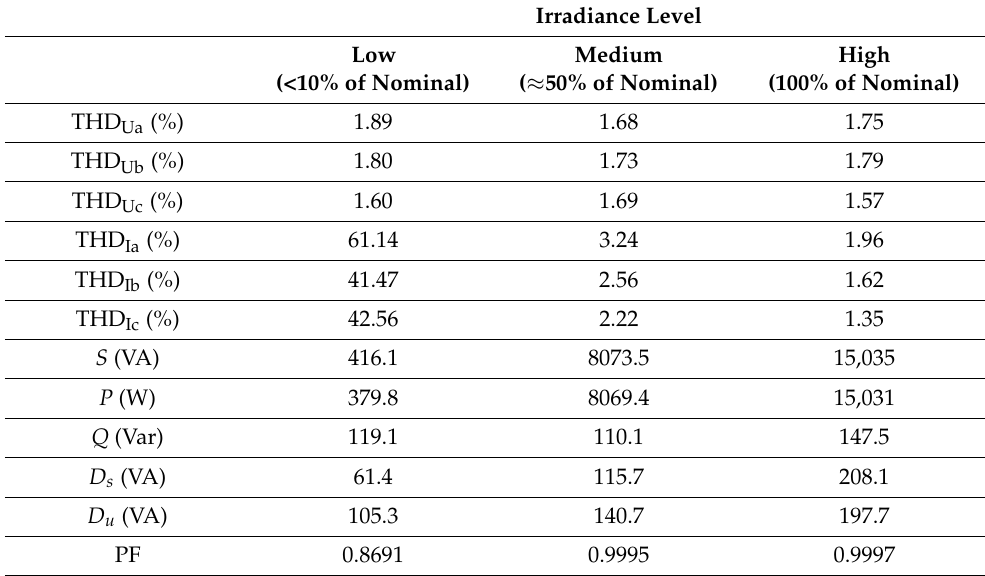
Table 2. The values of the parameters in an experimental approach for three different